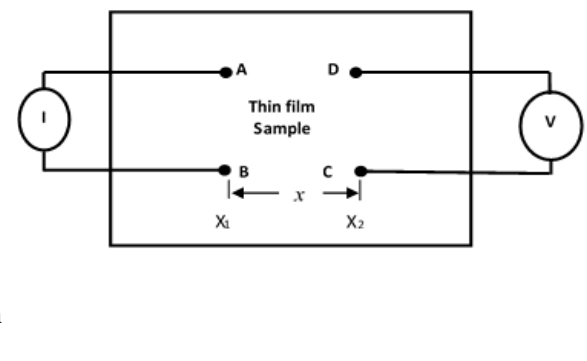
Figure 3. A schematic diagram showing the four points configuration used in making electrical measurements.